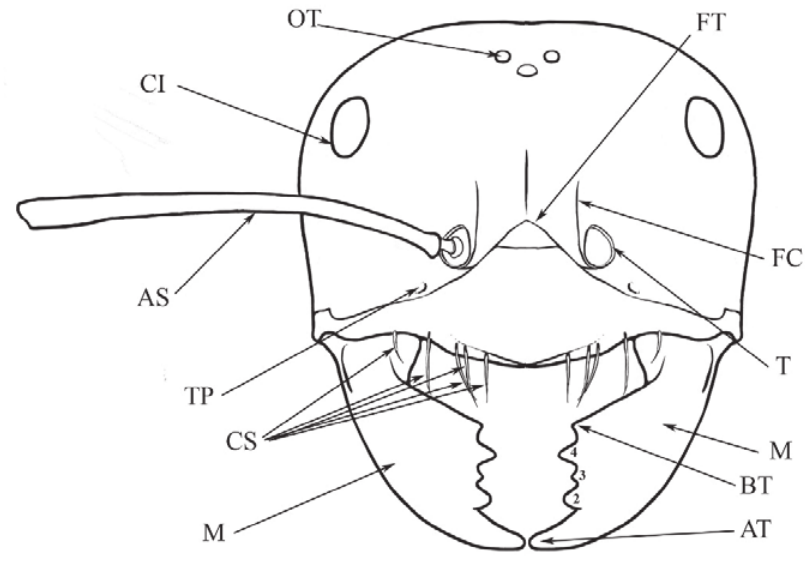
Figure 3. Frons of head of Melophorus showing structures mentioned in this monograph: As anten- nal scape At apical tooth Bt basal tooth Ci compound eye Cs clypeal psammophor e, c onsisting of a fringe of setae (nb. only those on RHS of head labelled) FC frontal carina Ft frontal triangle M mandible Ot ocellar triangl e, c onsisting of three ocelli (simple eyes) t torulus tP tentorial pit; 2, 3, 4, tooth se- quence commencing from the apical tooth.